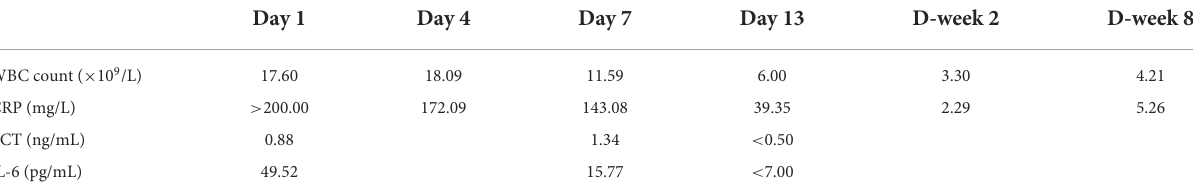
TABLE 1 Indicator of inflammation in this patient.